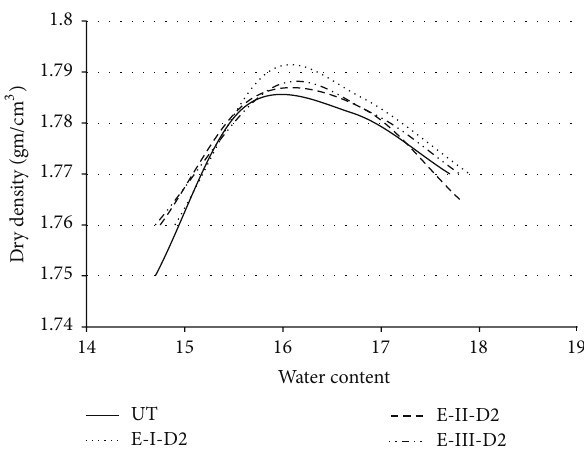
Figure 2: Compaction curves for untreated (UT) soil samples and soil treated with double dosage of the three different enzymes.